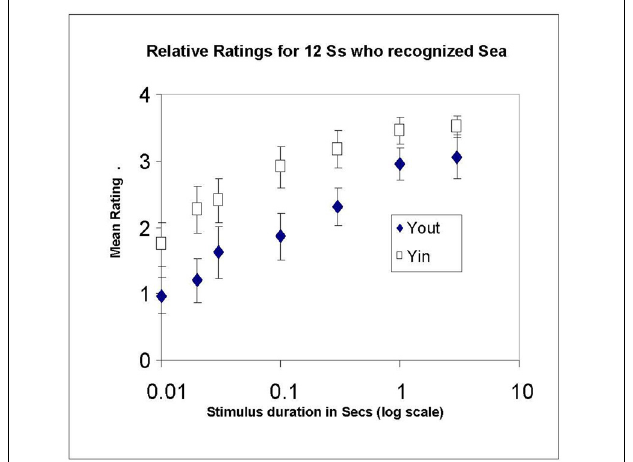
FIGURE 5 | Mean ratings in Experiment 3, made relative to a maximum of 4 for steady-state viewing of each illusory stimulus (Yin and Yout), plotted against stimulus duration in log s. Only recognizers were run. Error bars show ± 1 standard error of each mean.